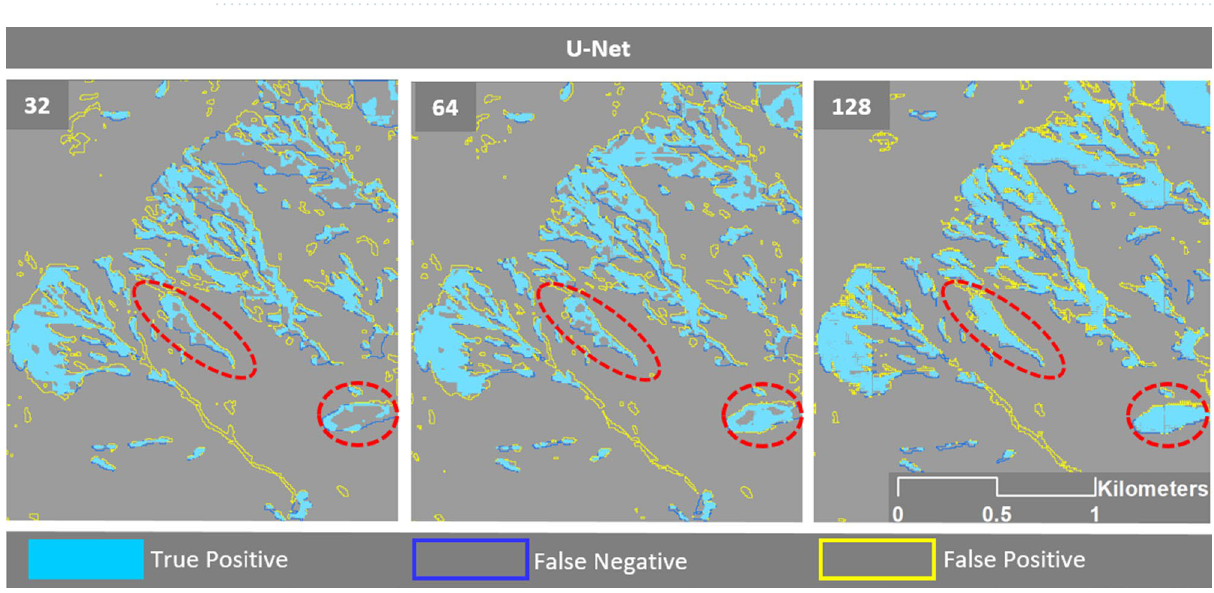
Figure 11. Comparison of the f1-score mean values for different sample patch window sizes (32 × 32, 64 × 64, and 128 × 128 pixels) in every scenario.